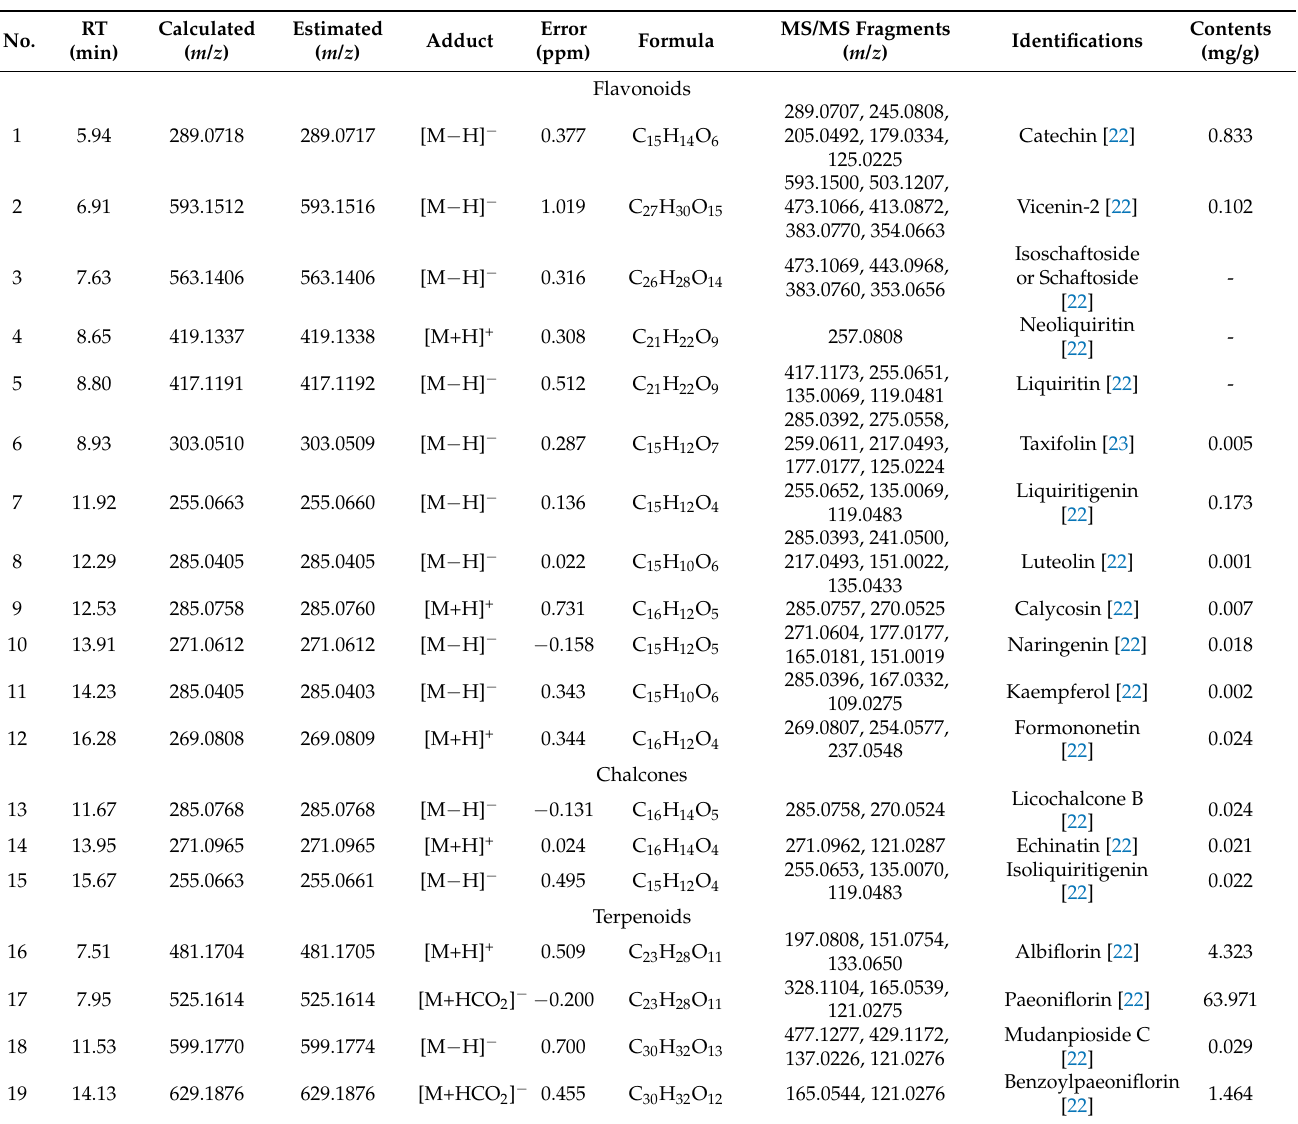
Table 1. Identification of phytochemicals in JGTW using